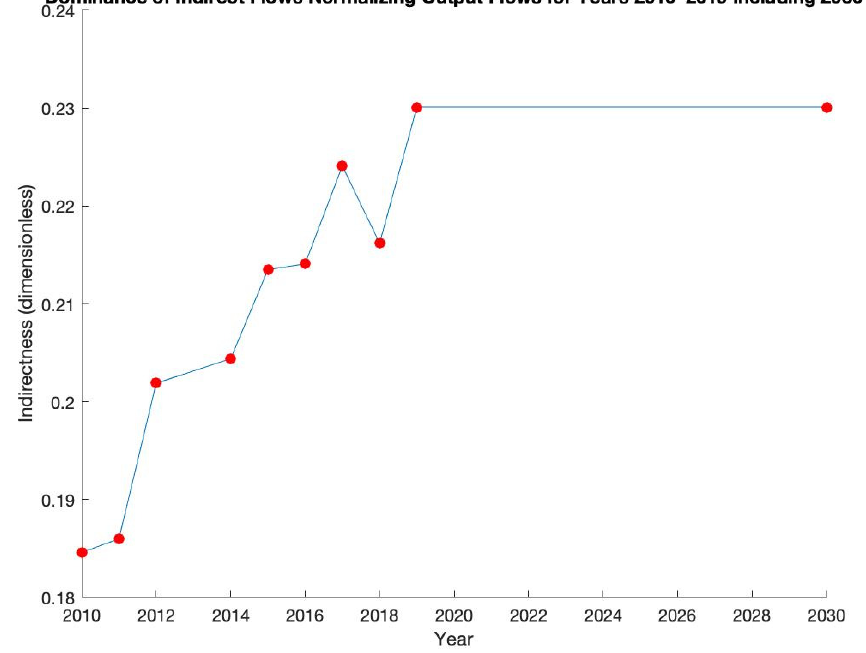
Figure 11. Indirectness normalizing output flows for Maryland’s energy industry from 2010–2019 including 2030.